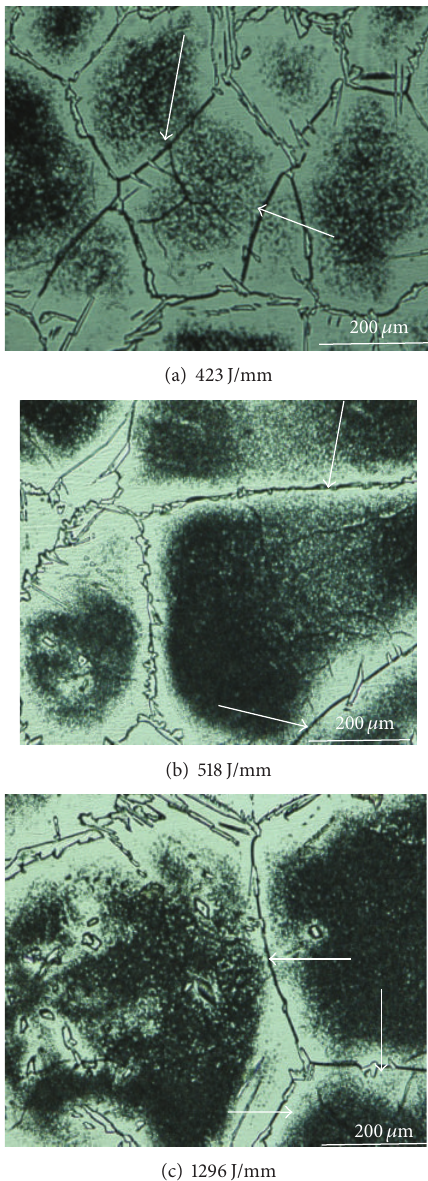
Figure 6: Microstructure of HTHAZ of conventional weld etched electrolytically in 10% oxalic acid. Figure 7: Microstructure of the HTHAZ of cryocooled weld etched electrolytically in 10% oxalic